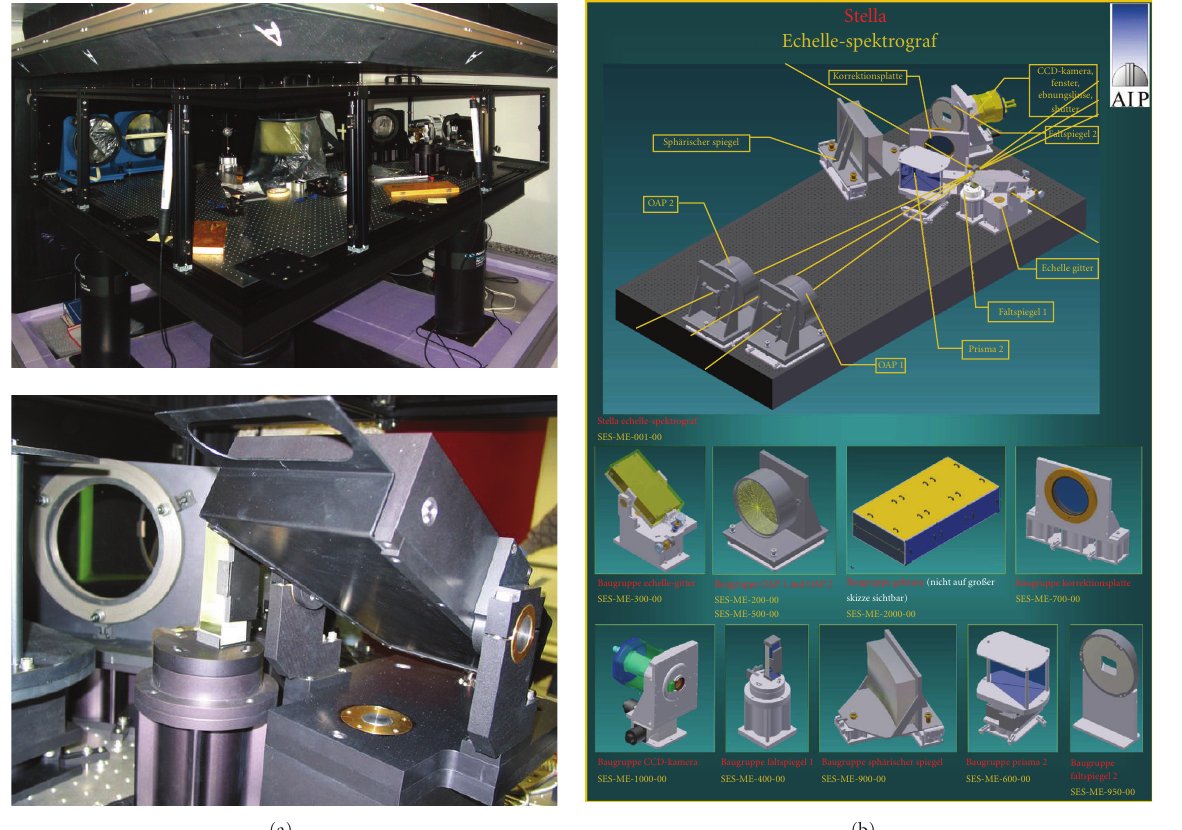
Figure 6: The STELLA Echelle Spectrograph (SES). (a) top: The instrument is mounted on a Newport optical bench on four gas-damped legs on a pier separated from the building. The table and its optical and mechanical components are enclosed with a dust cover made of anodized aluminium sheets (partly removed in this picture). This cover together with the bench legs is additionally enclosed in a thermal insulation chamber (also partly removed). This chamber is in a dedicated room with active temperature control. (a) bottom: The heart of the spectrograph, the R2 31-l/mm echelle grating (covered). (b) Overview of the opto-mechanical design and its components.